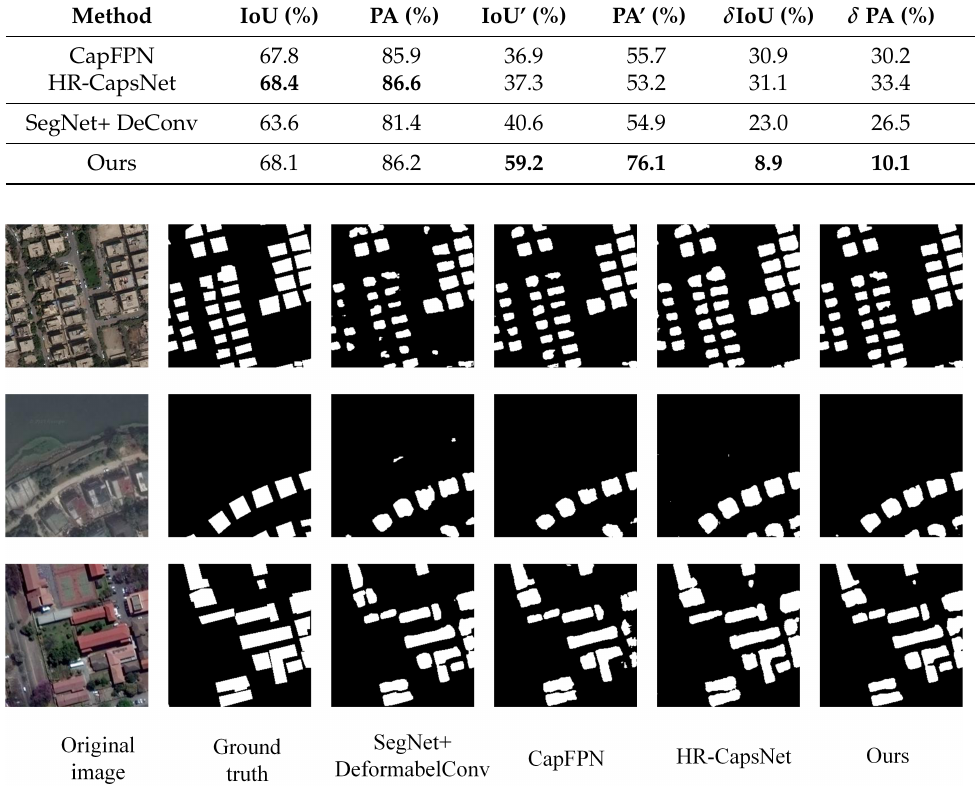
Figure 11. Comparison of the building extraction of different methods on the WHU dataset (WHU dataset as the source domain).